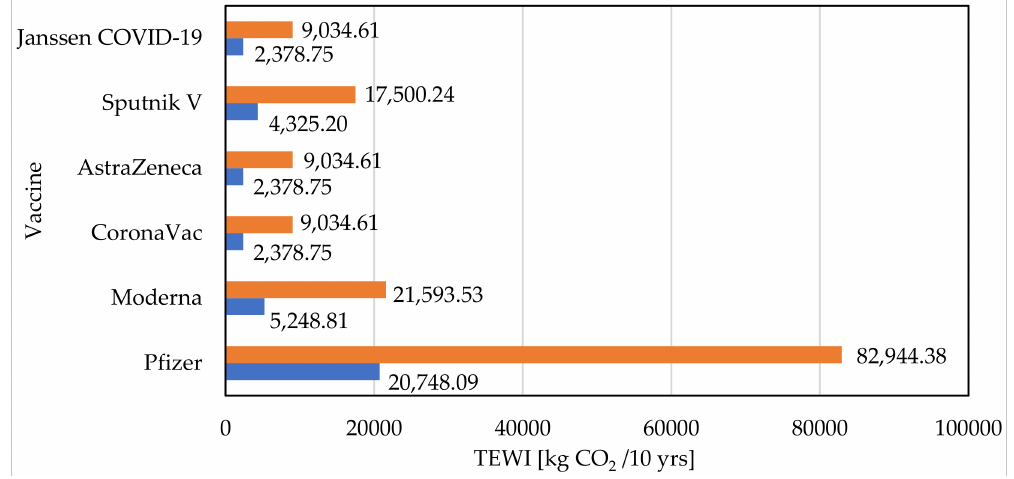
Figure 4. Comparison of TEWI values of 100,000 doses vaccine refrigeration in Brazil and the USA for 10 years. Legend: Brazil: (cid:4) ; USA: (cid:4) .